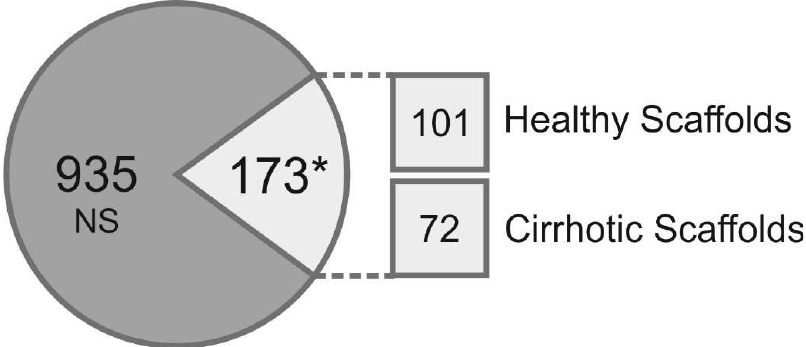
Figure 3. Proteomic analysis of healthy liver 3D scaffolds and cirrhotic liver 3D scaffolds. The composition of the ECM in decellularized healthy and cirrhotic liver scaffolds was qualitatively and quantitatively investigated by a label free proteomic analysis ( n = 3, three biological repeats, processed in triplicate for each condition). A relative quantitative analysis was performed on 1108 proteins showing 173 proteins significantly changed ( p < 0.05) between healthy scaffold and cirrhotic 3D scaffold ECM. In 3D healthy scaffolds, 101 proteins were overexpressed, whereas 72 proteins were significantly changed in decellularized 3D cirrhotic liver scaffolds.